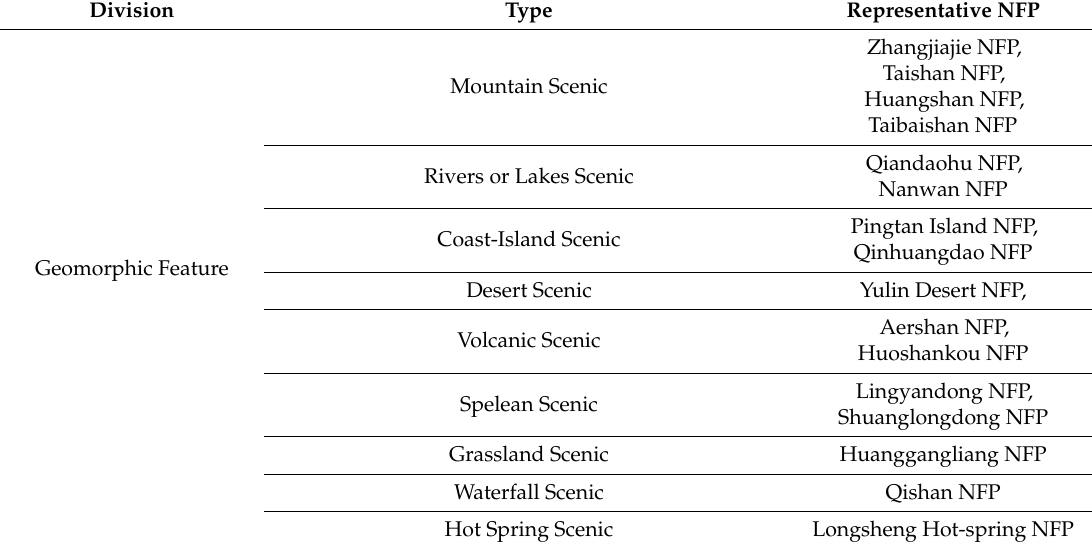
Table 3. Different categories of NFP with examples of specific areas. (Information collected from the official website of NFGA